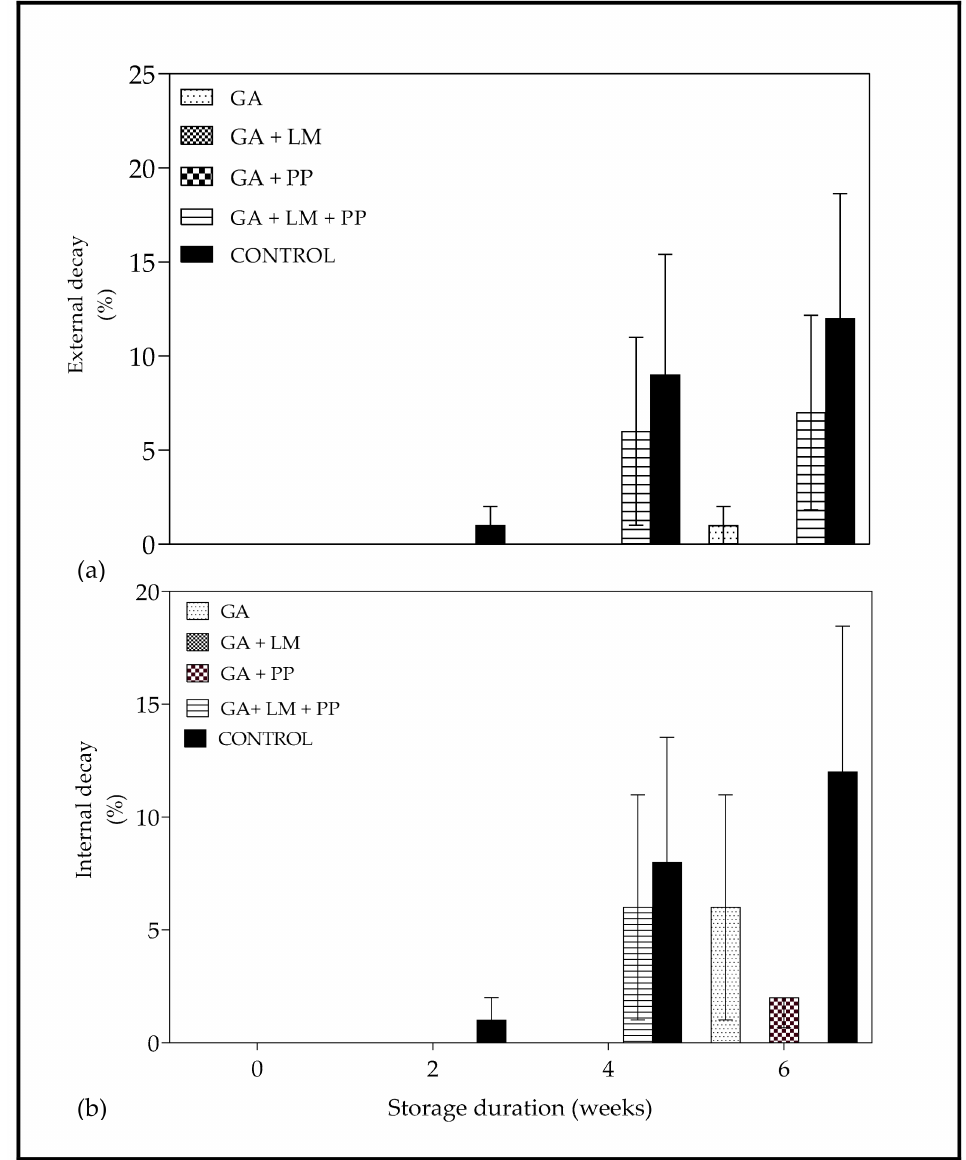
Figure 5. ( a ) External decay (%) and ( b ) internal decay of ‘Wonderful’ pomegranate whole fruit coated with gum arabic (GA) coatings enriched with lemongrass oil (LM) (0.1% v/v ) and/or pomegranate peel extract (PP) (1% w/v ), and stored at 5 ± 1 ◦ C (95 ± 2% RH) for 6 weeks. Ver- tical bars represent the standard error (SE) of mean values calculated from 10 measurements [1 carton (10 fruit) = 1